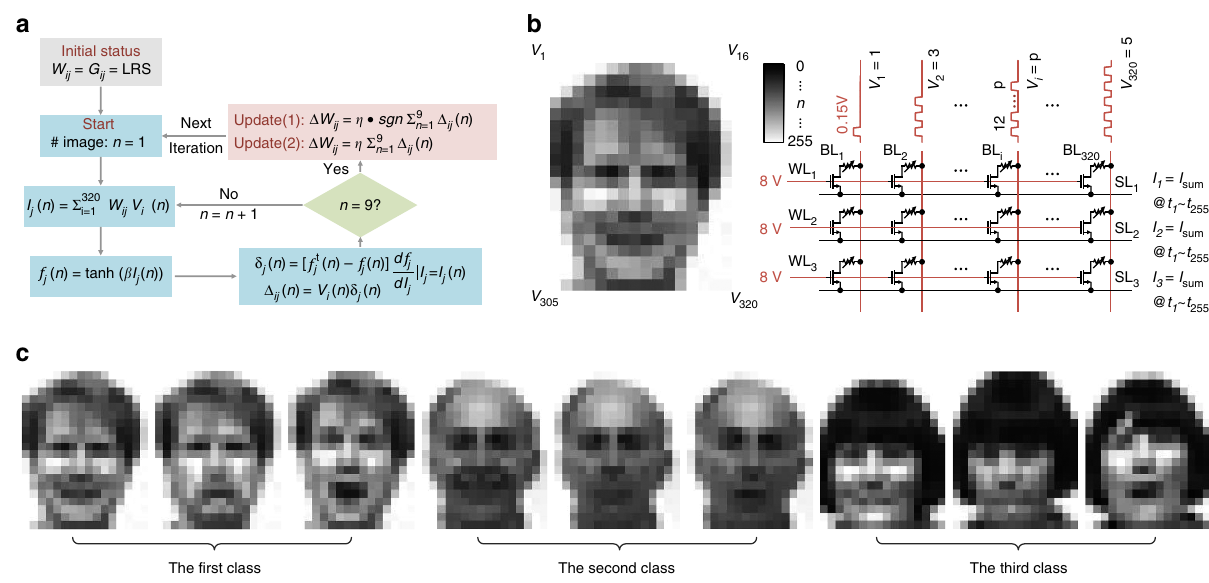
Figure 2 | Flowchart of the perceptron model. ( a ) The training process flow chart. In this demonstration, a batch learning model is used to accelerate the converging speed. Here ‘ n ’ represents the number of pattern, ranging from 1 to 9, ‘ i ’ implies the index of a pixel of an input pattern and can be defined from 1 to 320, ‘ j ’ is the number of output neuron that is 1–3. A correct classification during the inference phase means the active function value of a matching class of the input pattern is greater than other two classes. This network converges when all training patterns are correctly recognized. ( b ) The schematic of parallel read operation and how a pattern is mapped to the input. ( c ) The nine training images, which is a cropped and subsampled subset of the Yale Face Database 19 .